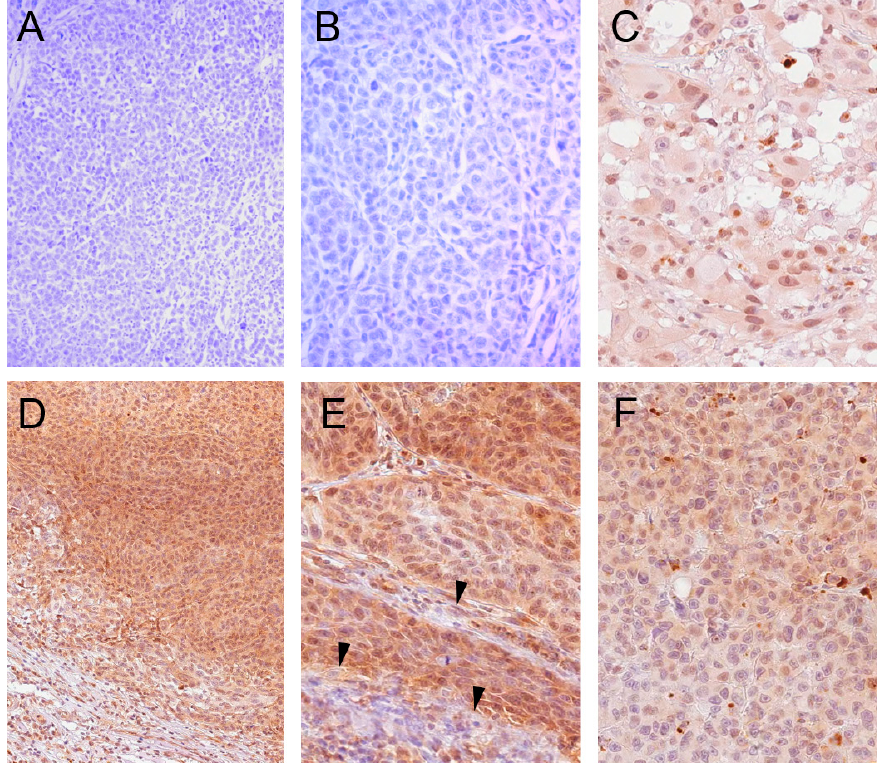
Figure 2. BCL2L10 is highly expressed in melanoma tumor samples. Representative images of immunohistochemistry staining for BCL2L10 using the PA5-22190 antibody (1:300 dilution) with hematoxylin counterstaining. ( A , B ) Representative images from a sample that scored negative for BCL2L10 staining ( A , 100× magnification, B , 200× magnification). ( C ) Sample showing predomi- nantly nuclear BCL2L10 staining (200× magnification). ( D , E ) Representative images from a sample showing nucleocytoplasmic BCL2L10 staining ( D , 100× magnification, E , 200× magnification). BCL2L10 staining is not observed in the adjacent stroma (at the bottom on panel D) and in the septal stroma (arrows in panel E). ( F ) Sample showing predominantly cytoplasmic BCL2L10 stain- ing (200× magnification).